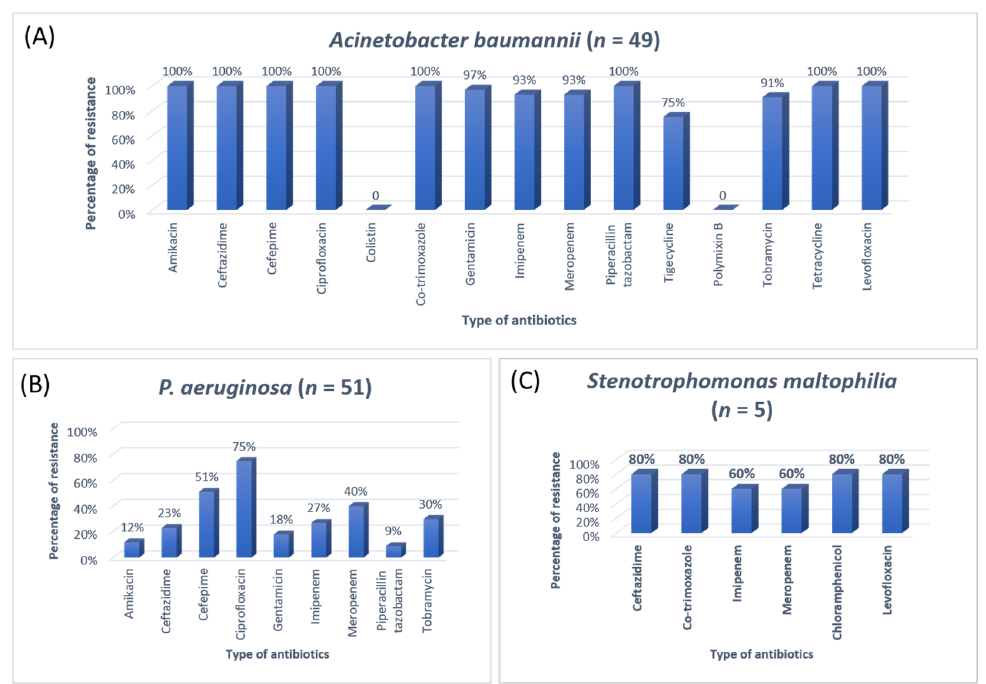
Figure 3. The antibiotic resistance patterns in ( A ) Serratia spp., ( B ) Citrobacter spp., ( C ) Proteus spp. * Not reported in urinary isolates. ** Only reported in urinary isolates.